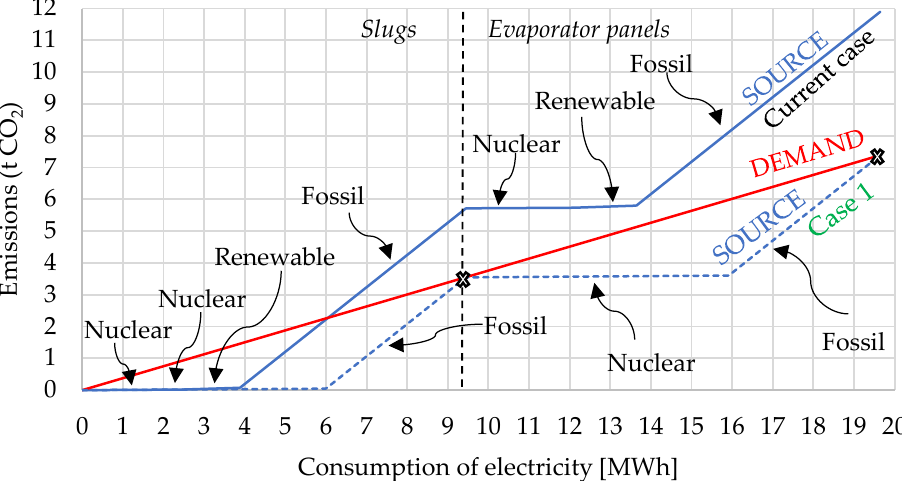
Figure 4. Pinch diagram for Case 1 when electricity consumption is pinched for each product.